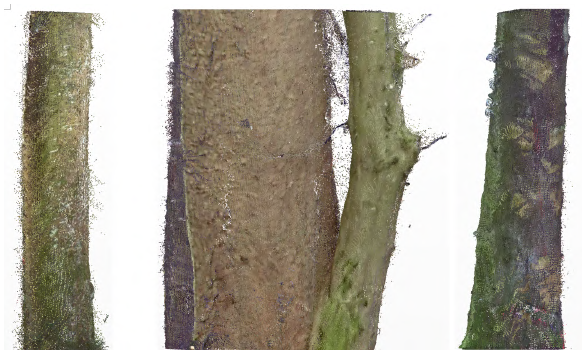
Figure 3. TLS point clouds: (left) Douglas Fir, (middle) Spruce and Hornbeam and (right)